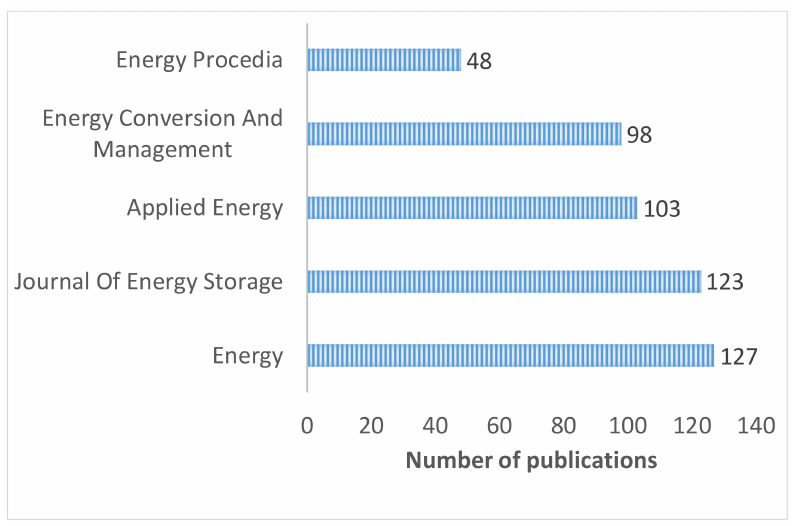
Figure 7. Top journals of paper published until September